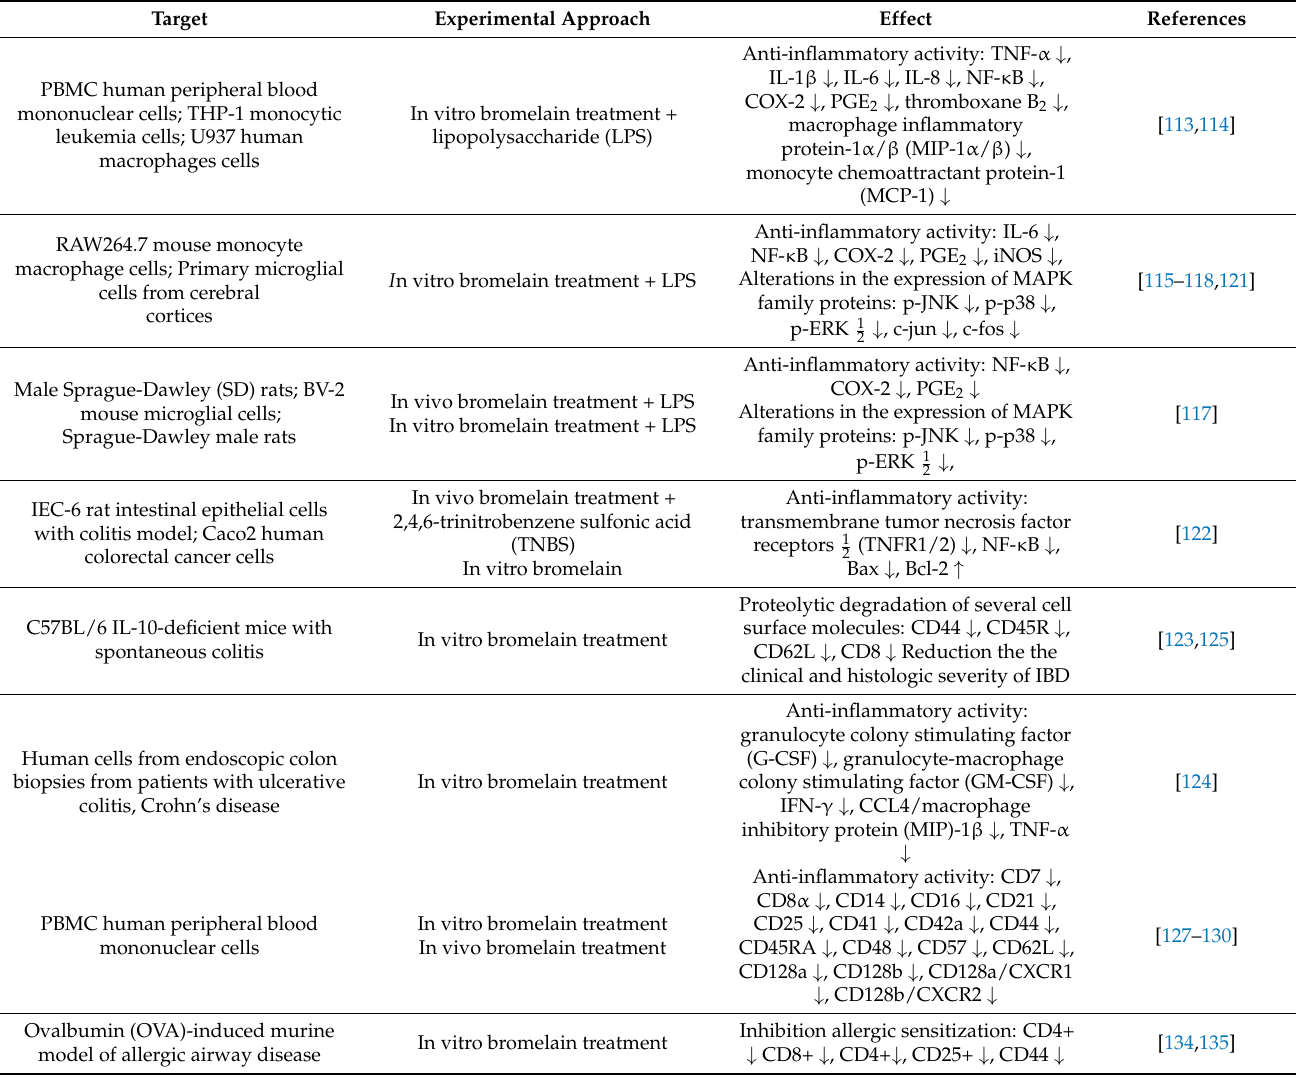
Table 1. Cellular and molecular targets of bromelain related to its anti-inflammatory and immunomodulatory activity. Target Experimental Approach